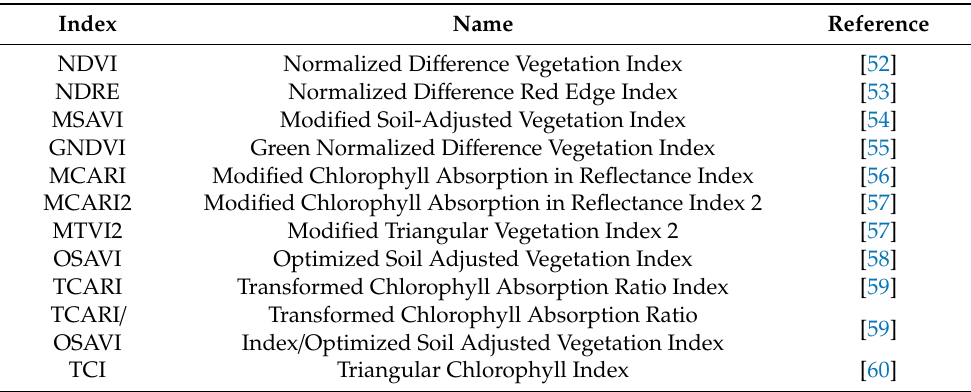
Table 3. List of vegetation indices used in the present